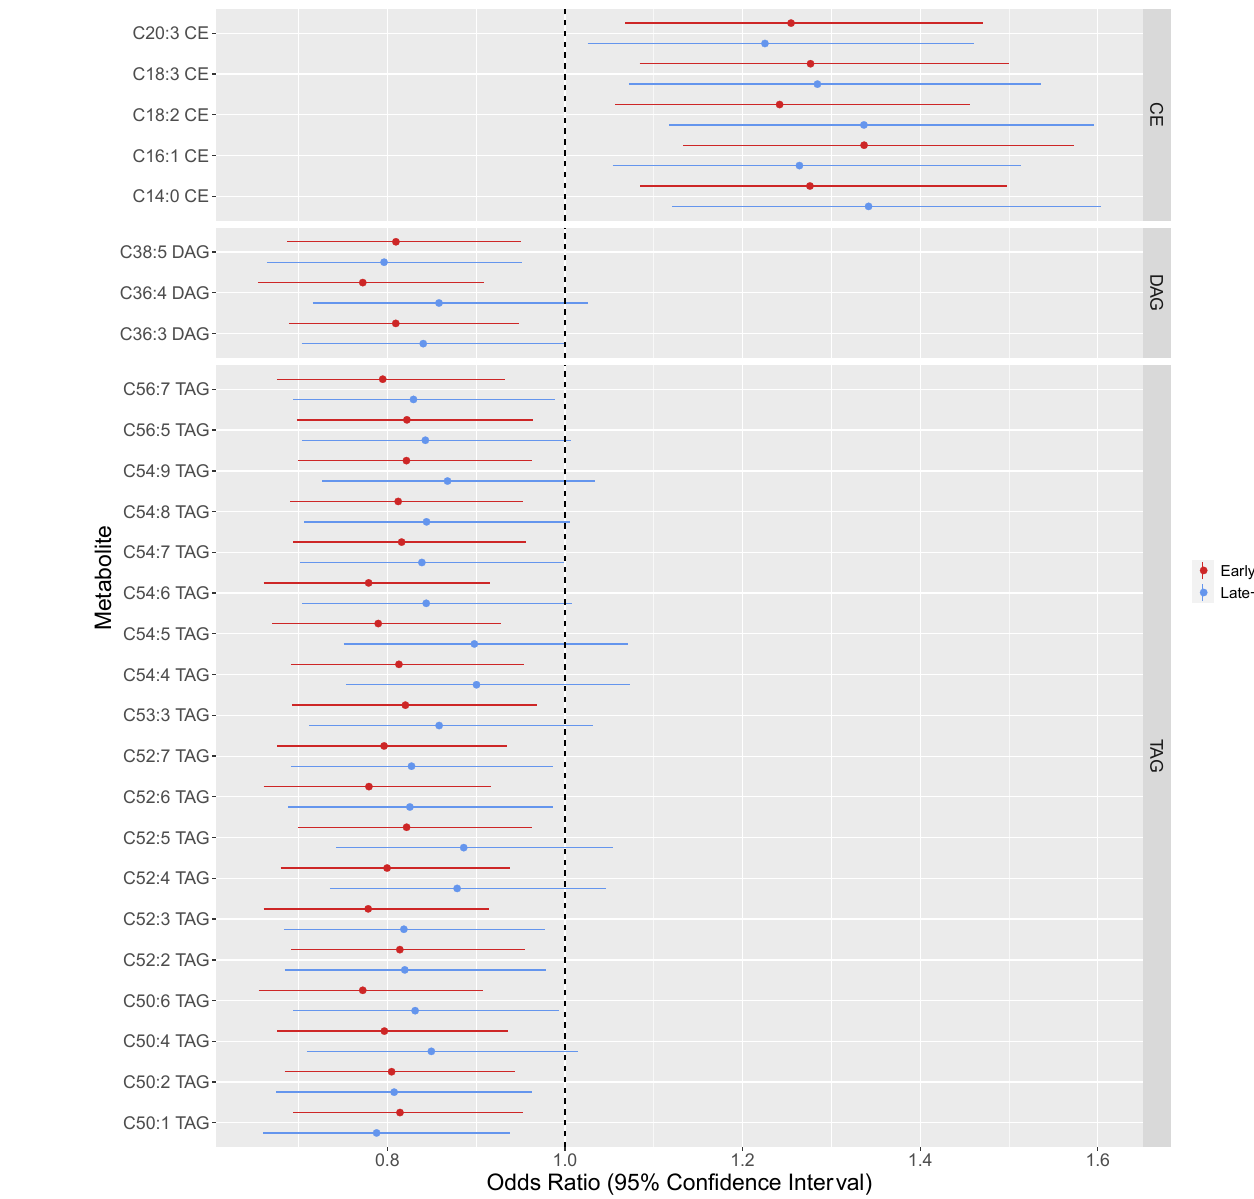
Figure 3. Longitudinal trajectory analysis: Forest plot showing associations of individual cord metabolites within each significant cluster (as identified in Table 2 with p -value ≤ 0.05 for either comparison) with child BMI trajectory groups (early-OWO and late-OWO as compared to NW) from multinomial logistic regression model results. Only metabolites with FDR of early-OWO vs. NW comparison less than or equal to 0.05 are listed here (results for all 68 metabolites in the 2 candidate metabolite modules identified in Table 2 are listed in Supplementary Table S3). Within each panel (metabolite type), individual metabolites are ordered based on FDR of early-OWO vs. NW comparison. FDR accounts for multiple hypothesis testing across all 68 metabolites in the 2 candidate metabolite clusters identified in Table 2.